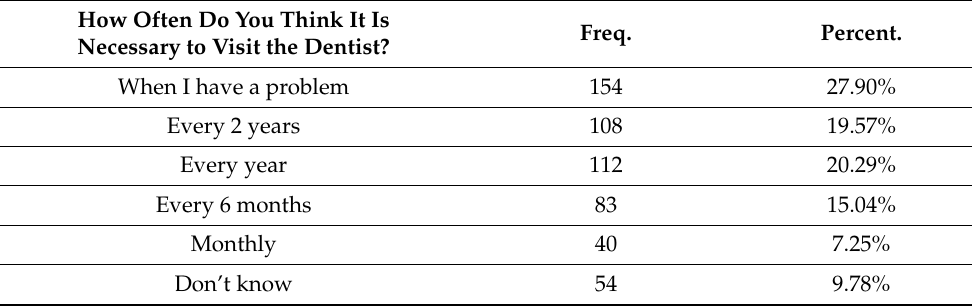
Table 5. Frequency of dental check-ups.